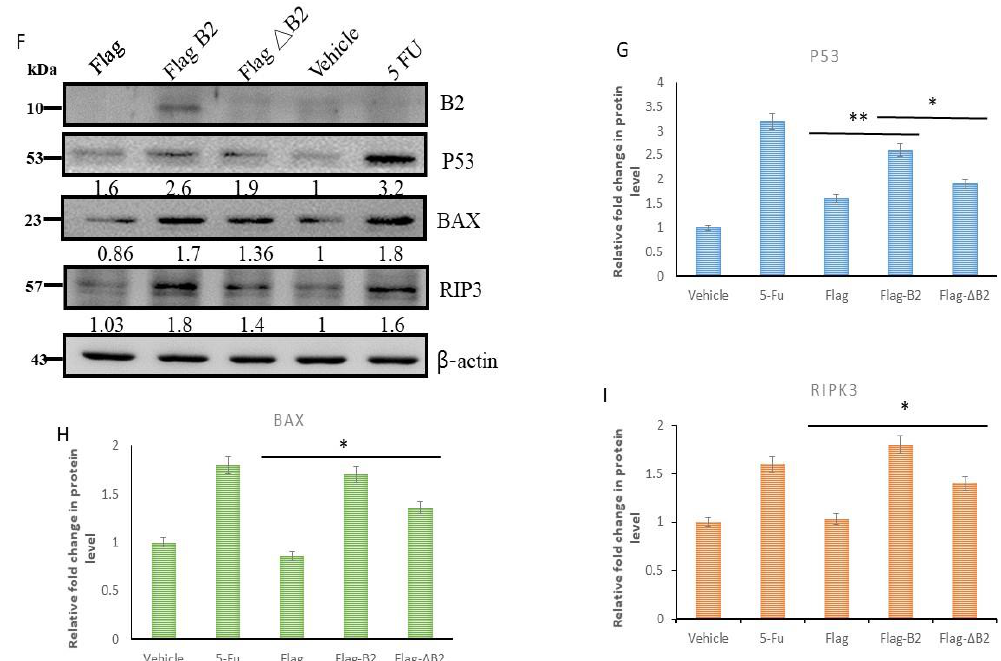
Figure 6. B2 expression can trigger two different cell death pathways. ( A ) Tissue section analysis of A549 cell solid tumors by H&E staining. Cell damage sites are indicated by arrows in B2-expressing cells. RT-qPCR analysis of gene expression of ( B ) B2 and mRNA expression of ( C ) p53 and ( D ) Bax, suggesting the induction of the p53/Bax-mediated apoptotic pathway. ( E ) RT-qPCR analysis of RIPK3, suggesting the induction of RIPK3-mediated necroptosis in solid tumors ( N = 4–6). The data are representative of three separate experiments, and the error bars represent the SEMs. * p < 0.05 and ** p < 0.01, as analyzed by one-way ANOVA with Tukey’s multiple comparisons. ( F ) Upregulation of the B2-mitochondria-targeting-induced P53/Bax-mediated apoptosis death pathway ( G , H ) and the RIPK3-mediated necroptosis pathway ( I ) in A549 cell solid tumors according to Western blot analysis. ( F – I ) Quantification of the results in F. The data are representative of three separate experiments, and the bars represent the SEMs. * p < 0.05 and ** p < 0.01, as analyzed by one-way ANOVA with Tukey’s multiple comparisons.